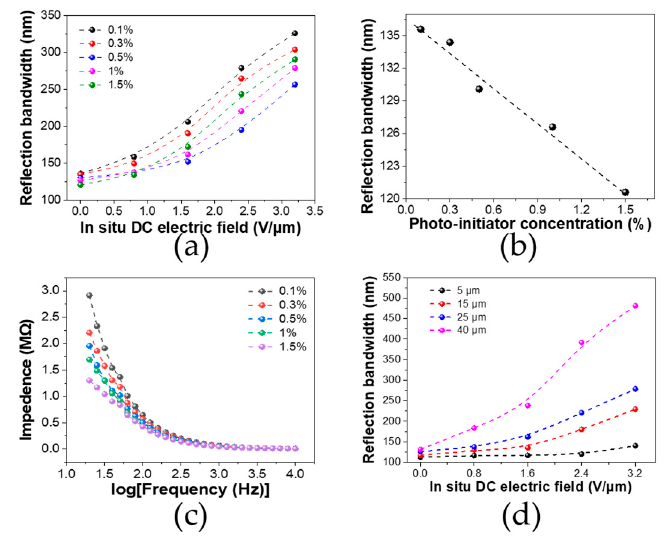
Figure 5. ( a ) Reflection bandwidth of the cell with different initiator concentrations treated with an in situ electric field; ( b ) reflection bandwidth of the cell without an in situ DC electric field as a function of different initiator concentrations; ( c ) impedance spectra of the cells with different photo-initiator concentrations; ( d ) reflection bandwidth of PSCLC cells with different thicknesses treated with an in situ DC electric field.